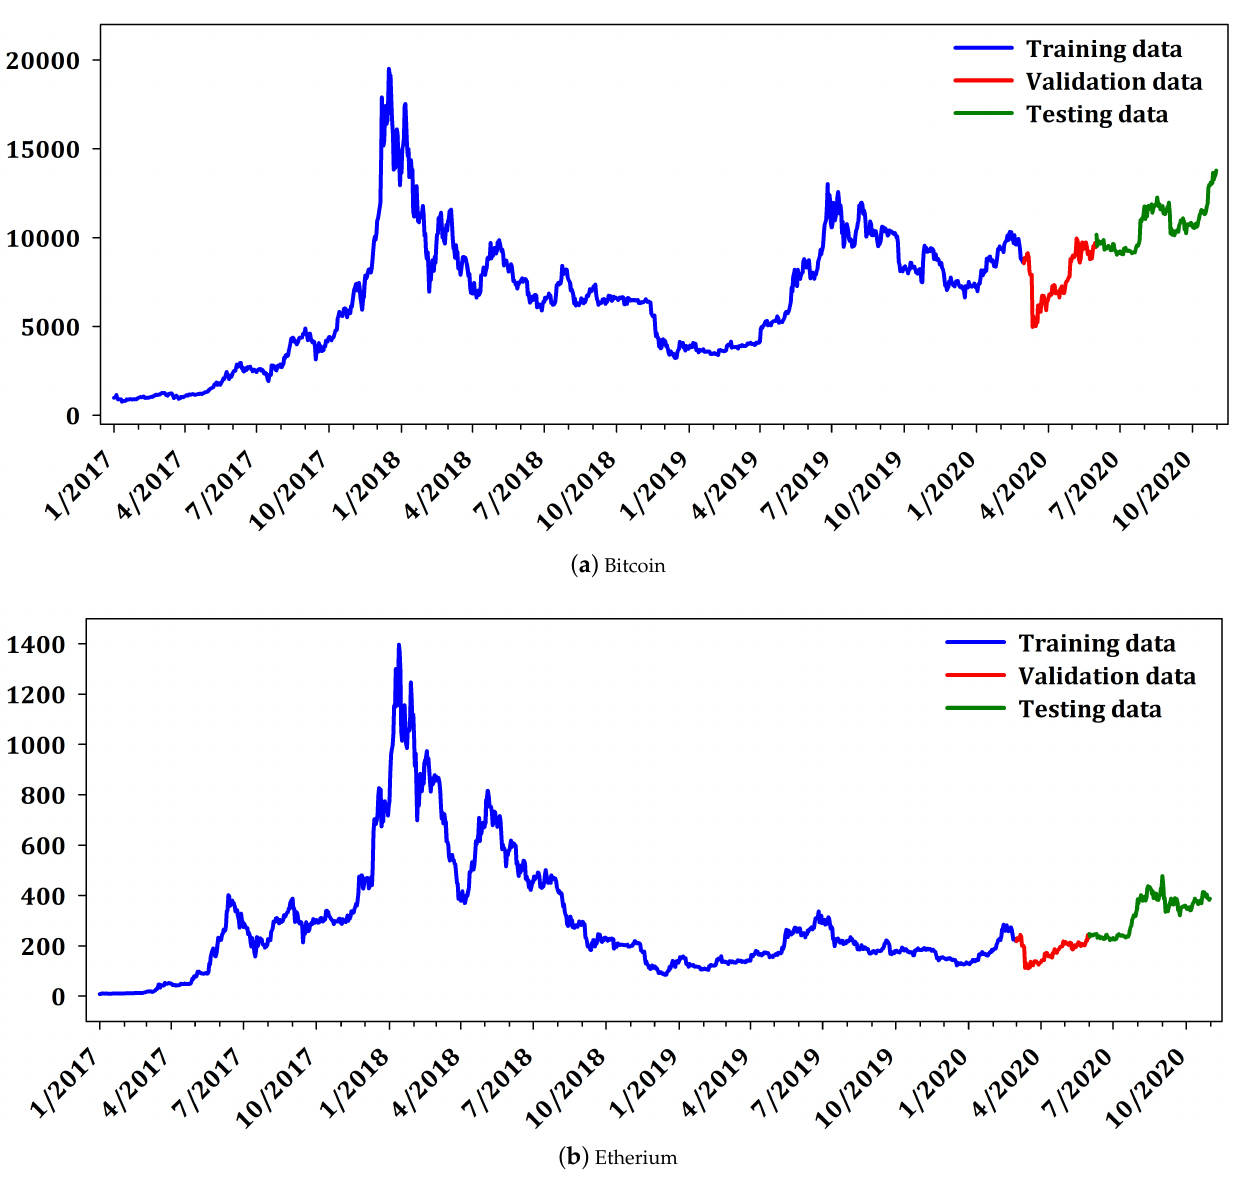
Figure 2. Cont Figure 2. Cont . Figure 2. Cont .